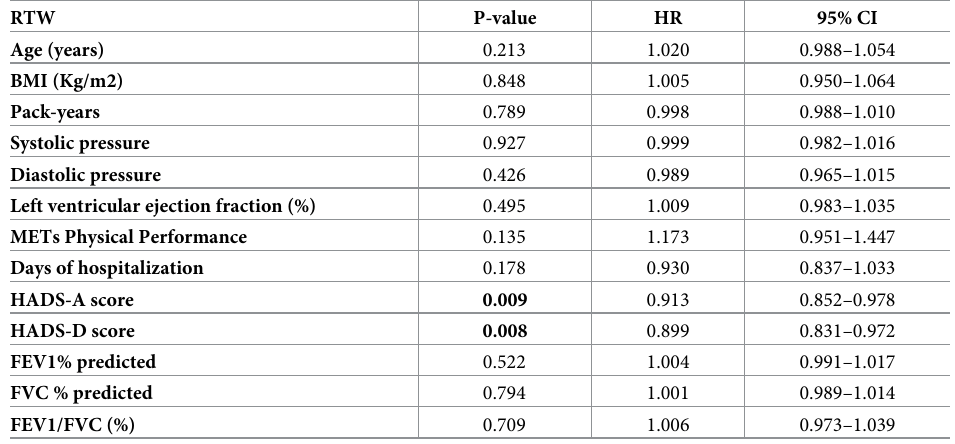
Table 4. Univariate Cox regression of the association between timing of return to work status (RTW) and quanti- tative clinical, functional, psychological and socio-demographic variables. RTW P-value HR 95% CI Age (years) 0.213